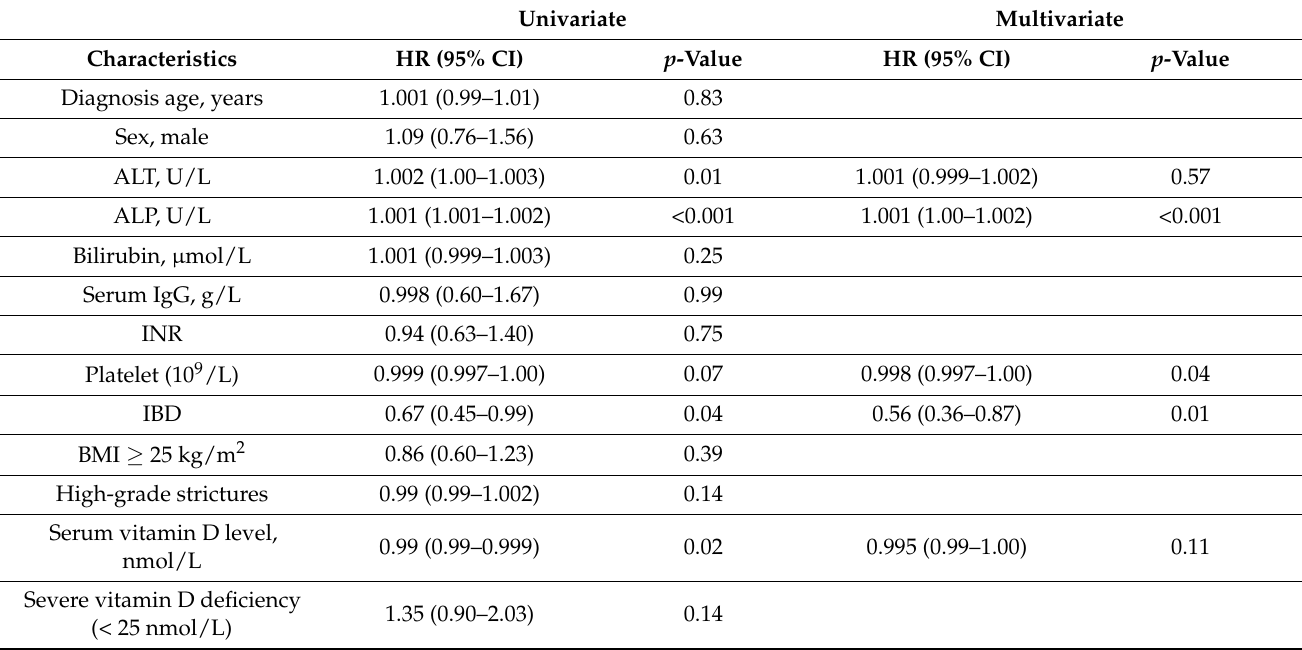
Table 2. Features Associated with Cirrhosis Development in PSC.